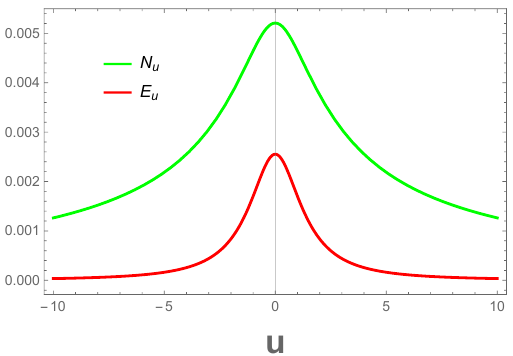
Figure 8. The continuous time evolution of particle creation, Equation (36), and time evolution of energy quanta, Equation (37). Here κ = 1 (though N u / κ and E u / κ 2 have invariant forms as a function of κ u